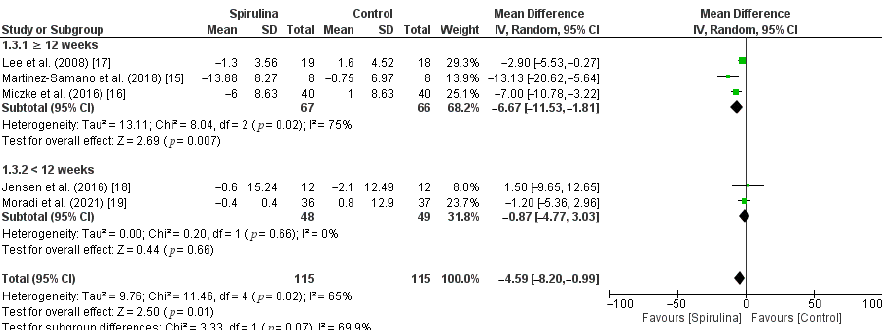
Figure 6. Effect of Spirulina supplementation on systolic blood pressure (SBP) compared with the control group stratified by baseline blood pressure [15–19]. 3.4. Effect of Spirulina on Diastolic Blood Pressure Pooled analysis of 4 RCTs showed that Spirulina intake significantly lowered DBP (MD: −4.29 mmHg, CI: −8.43 to −0.14, I 2 = 81%) in comparison with the control group. However, the above analysis showed unacceptable heterogeneity (I 2 = 81%). Therefore, based on the sensitivity analysis, we found and eliminated the study [19] that caused high heterogeneity (Figure 7a). After re-analysis, which accounted for the exclusion of the above study, we noticed highly significant lowering of DBP in the Spirulina group (MD: −7.02 mmHg, CI: −8.86 to −5.18, I 2 = 11%) compared with the control group (Figure 7b).